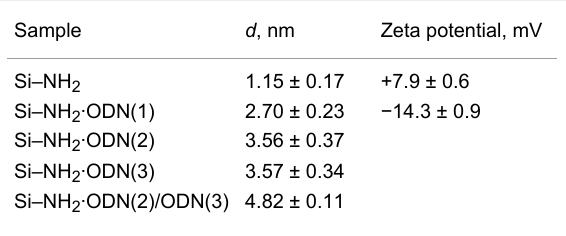
Table 1: Hydrodynamic diameter and zeta potential values of Si–NH 2 and Si–NH 2 ·ODN.